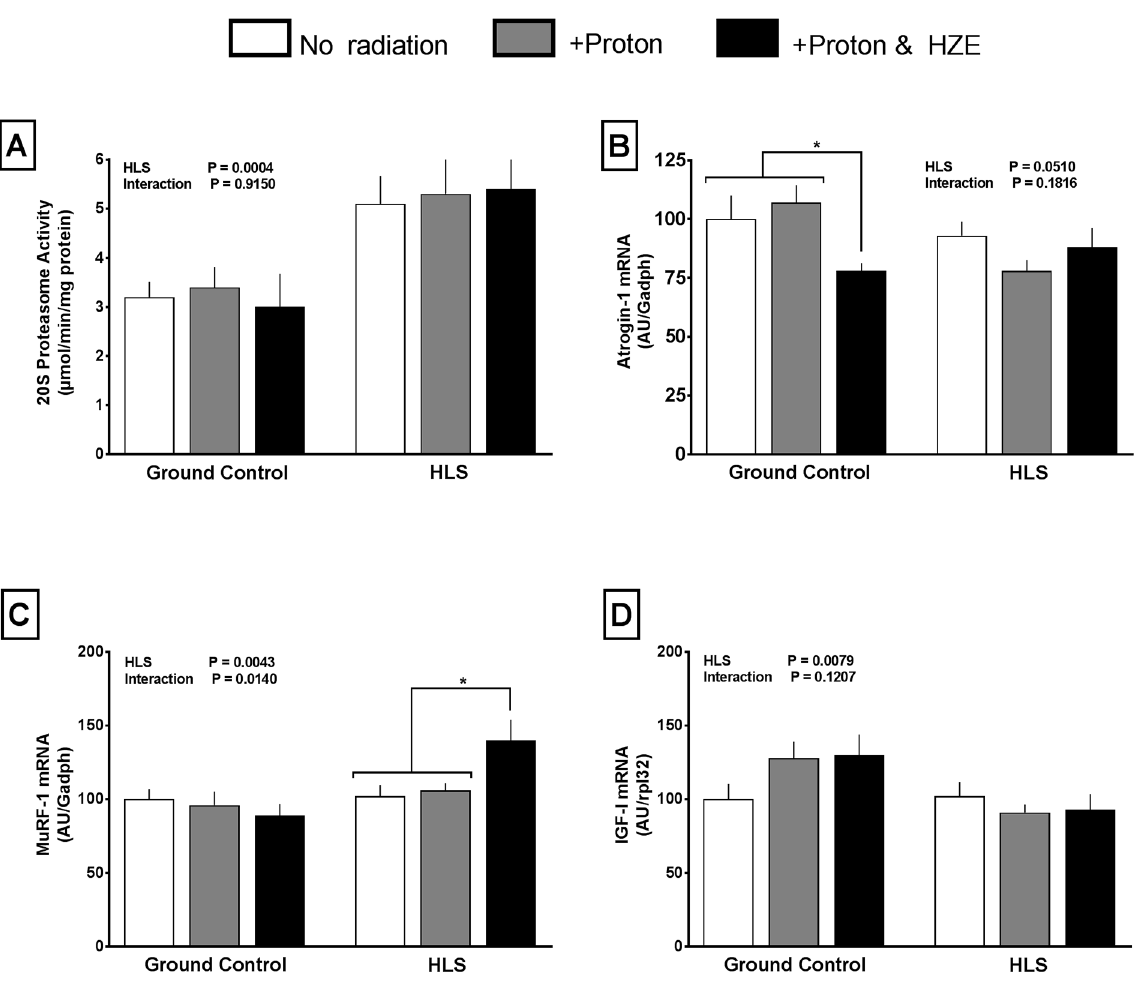
Fig 7. Effect of HLS and radiation on 20S proteasome(A), atrogin-1 (B), MuRF-1 (C), and insulin growth factor (D) expression. Measures are absolutevalues at conclusionof study. Values are means ± SEM; n = 14-18/group, Values with line and asterisk indications are significantly different (p <